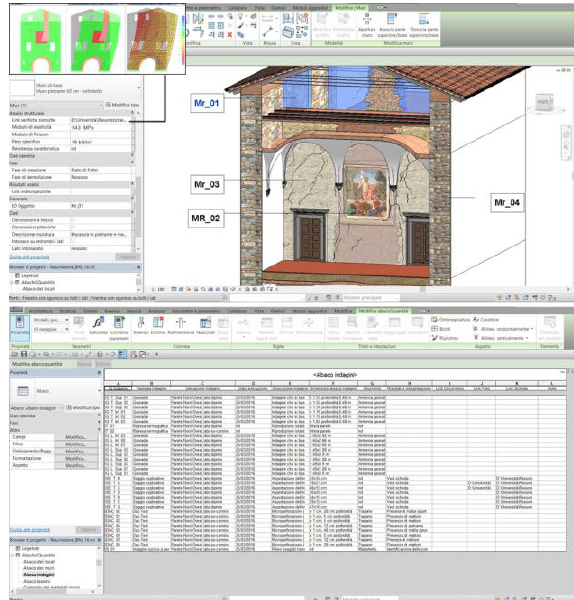
Figure 8. Up: the identification of the walls by label, the visualization of the parameters connected to the object-wall with the link to the dynamic analysis card. The modeling of the fessures pattern is also visible. Down: an example of abacus that allow to manage all the